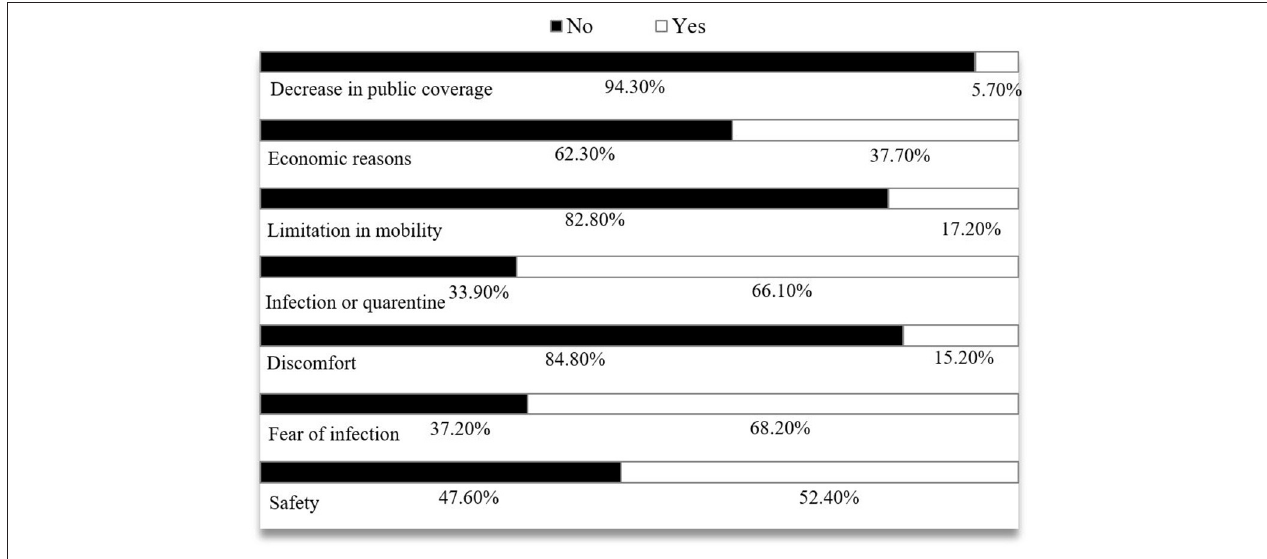
FIGURE 1 | Reasons provided by the physical therapists that resulted in the reduction of scheduled appointments during the